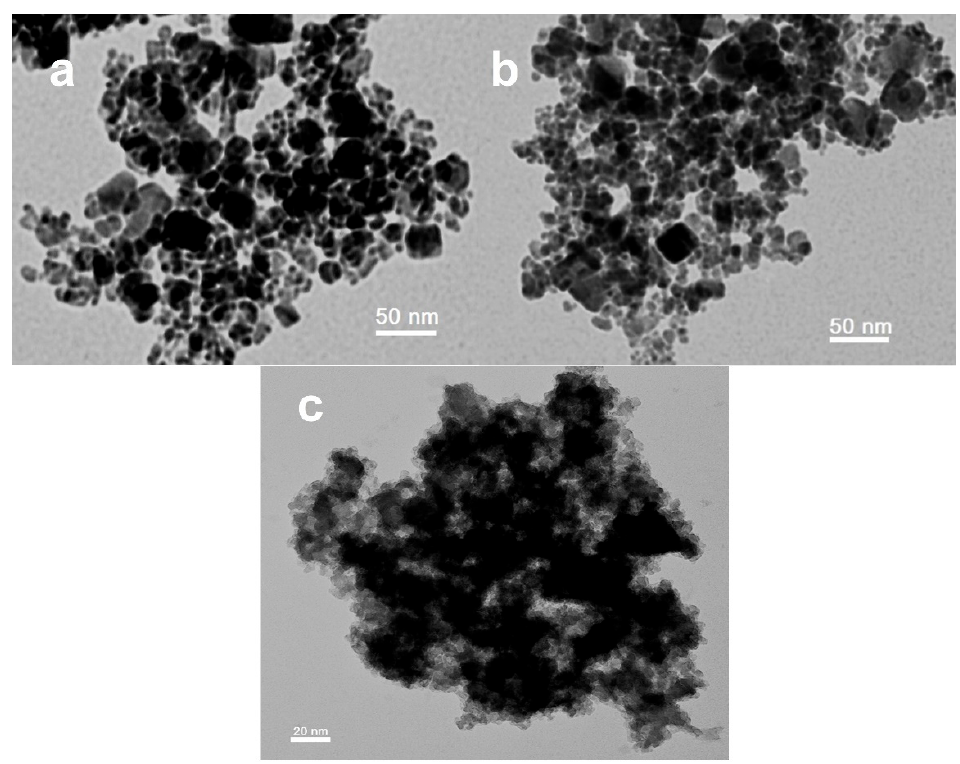
Figure 2. TEM images of magnetite ( a ), magnetite-LiP ( b ) and sol–gel encapsulated magnetite-LiP-silica composites ( c ).